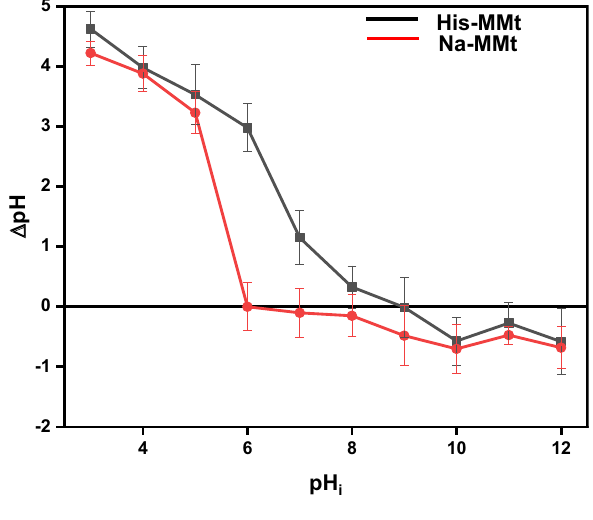
Fig. 1 PZC of Na-MMt and His-MMt